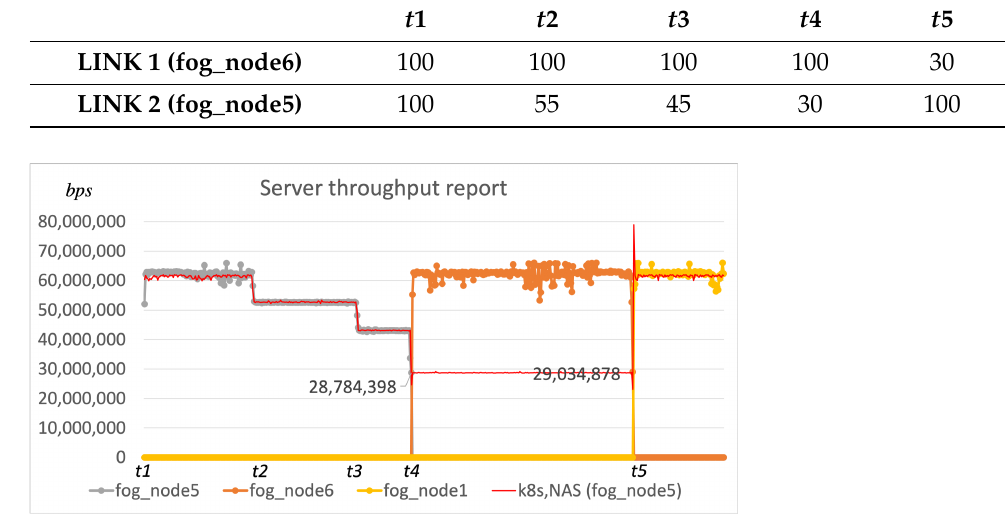
Figure 7. Throughput reported by the data reception service (traffic generation speed: 66